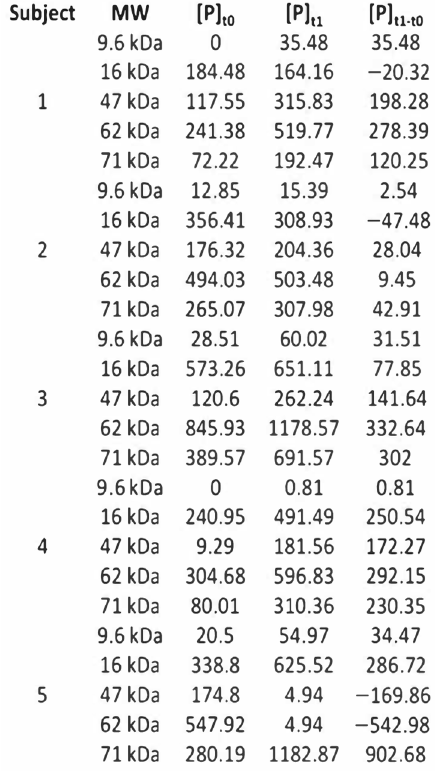
Figure 1. Power analysis and sample size study, using the ∆ [P] after-before (experimental procedure). The five preliminary subjects’ protein concentrations and change/variability (ng/µL) are presented. Five MWs of interest were used to estimate a potency (T-Student) of 80%, a significance level of 5%, and an effect size of 40%.